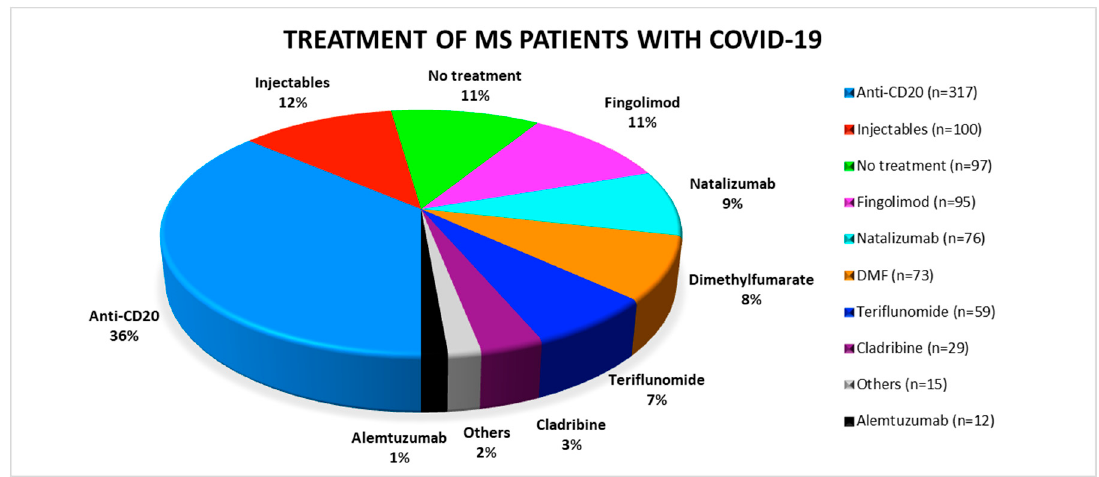
Figure 1. Distribution of the respective disease modifying therapies among the published SARS-CoV- 2 positive multiple sclerosis patients. COVID-19: coronavirus disease 2019; DMF: dimethyl-fumarate; MS: multiple sclerosis.